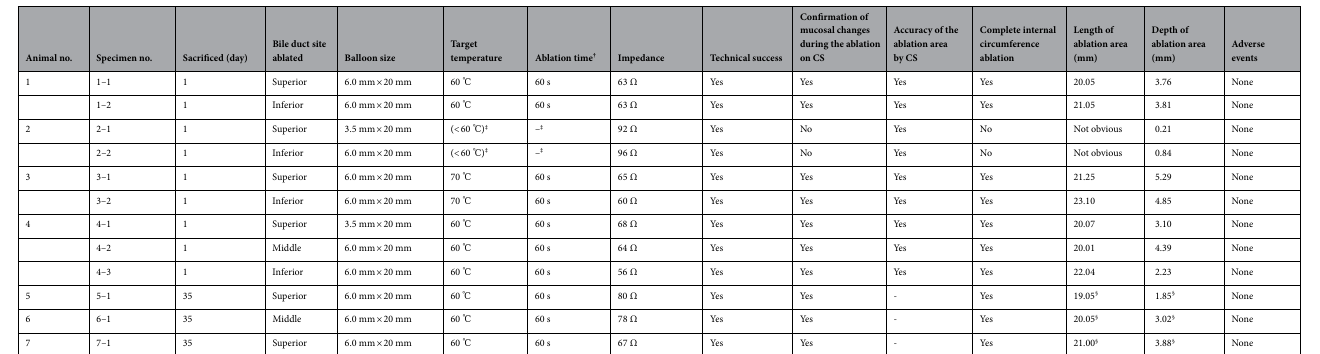
Animal no. Specimen